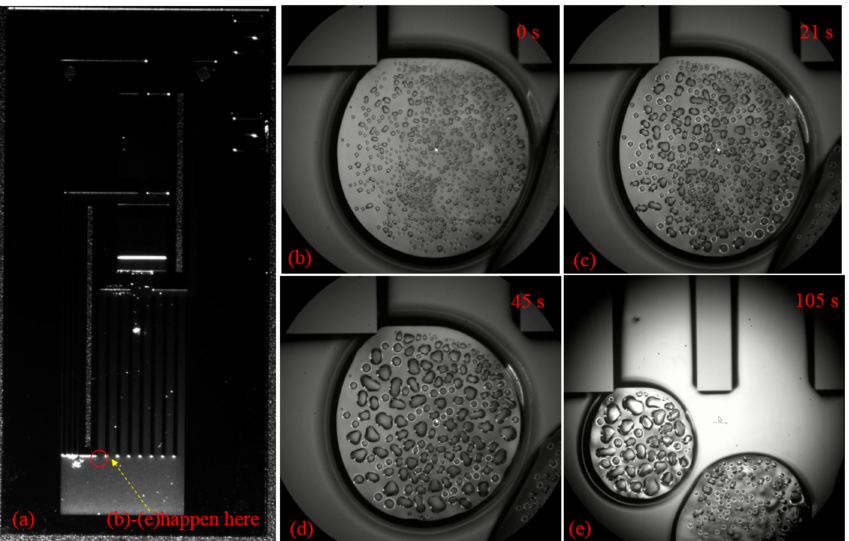
Figure 9. Bubble condensation process in the condensation chamber: ( a ) illustrates where ( b – e ) occur in the condenser; ( b – e ) are the images at 0 s, 21 s, 45 s and 105 s respectively. There were many obvious droplets in the deionized water working fluid